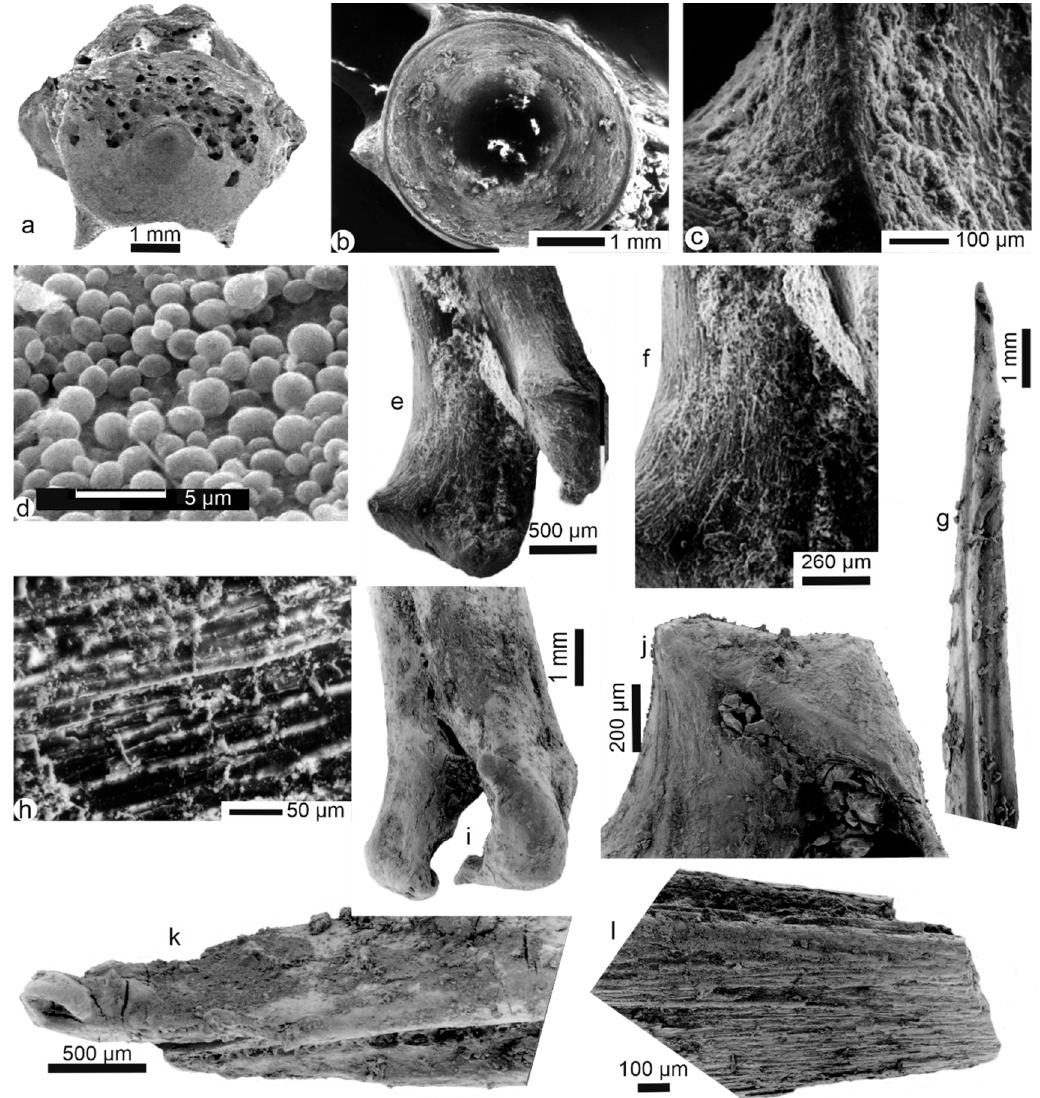
Figure 3. Fish bones from eagle owl pellets, Namalenje Island, Salima, Malawi Lake border. ( a ) Vertebra centrum showing digestion holes, and broken apophyses. ( b ) Outer surface of a light digested vertebra showing the central hole and broken apophyses. ( c ) Outer surface of a vertebra showing secondary deposits. ( d ) Detail of the central part of Figure 3b, showing rounded particles. ( e ), ( f ) Secondary deposits and remains of flesh on the articular extremity of a spine. ( g ) Well preserved spine with punctual secondary deposits. ( h ) Surface of a long bone showing erosion of the external layers. ( i ) Secondary deposits on the articular extremity of a spine bone with polished epiphyses and tiny holes resulting from very light digestion. ( j ) Detail of the articular zone of another spine with some small holes filled with secondary deposits. ( k ) Secondary deposits on a digested spine with twisted extremity. ( l ) Eroded (weathering) surface of a broken spine.